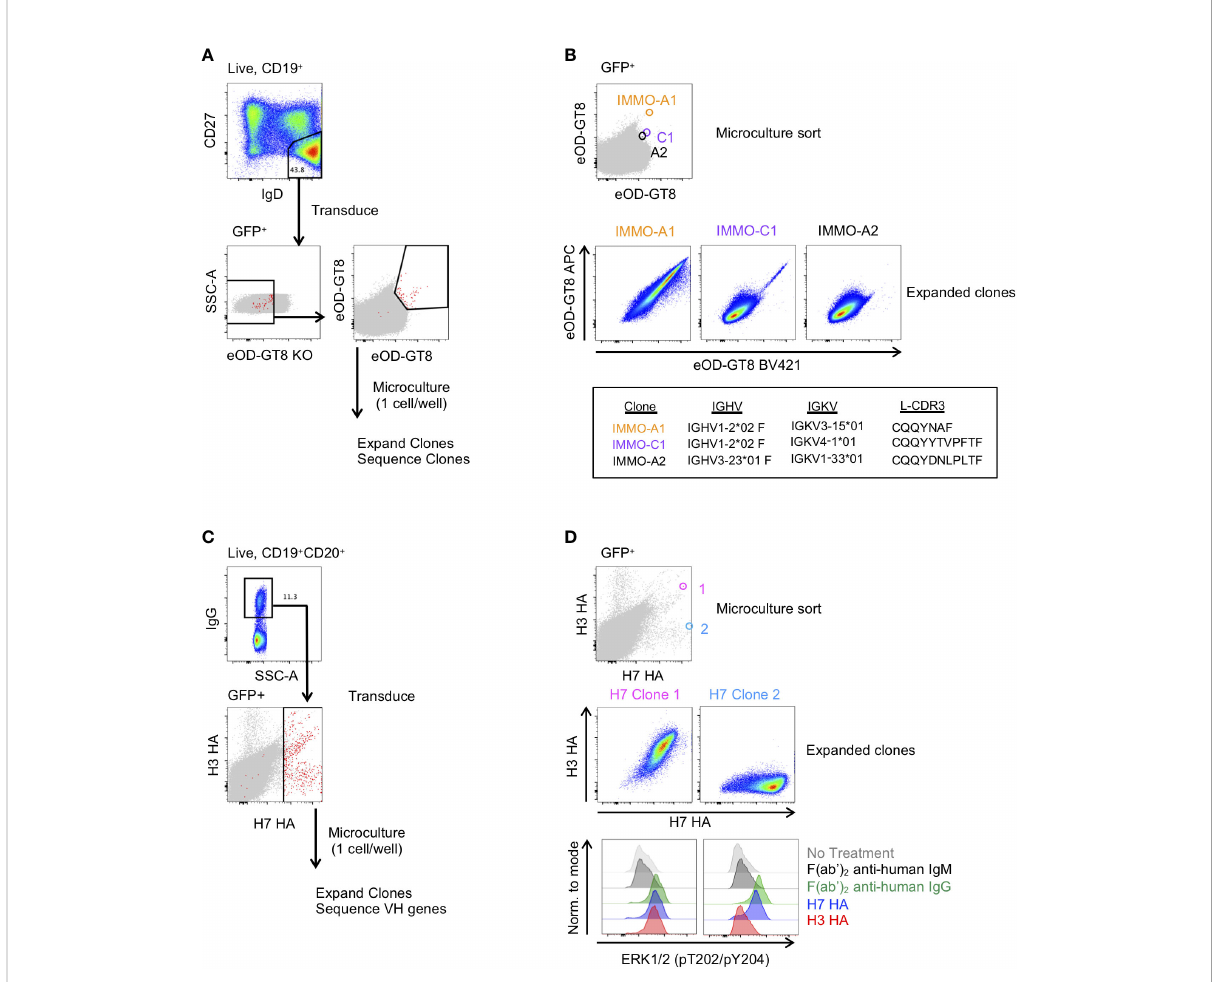
FIGURE 3 Generation of antigen-speci fi c clonal B cell lines from naïve and memory B cell subsets. (A) Isolation of VRC01-class precursor B cell clones from the naïve B cell subset. (B) Characterization of 3 of the isolated clones binding to the eOD-GT8 probe during the microculture sort (top), following clonal expansion (middle) and their immunogenetic properties (bottom). (C) Isolation of H7 HA-speci fi c B cells from vaccinated individuals. (D) Characterization of 2 of the isolated clones and their binding properties to the H7 and H3 HA probes (Top: Individual GFP+ B cells binding to the H7 and H3 HA probes during the microculture sort; Middle: binding properties to H7 and H3 HA after clonal expansion; Lower: BCR activation as determined by phosphorylation of ERK by fl ow